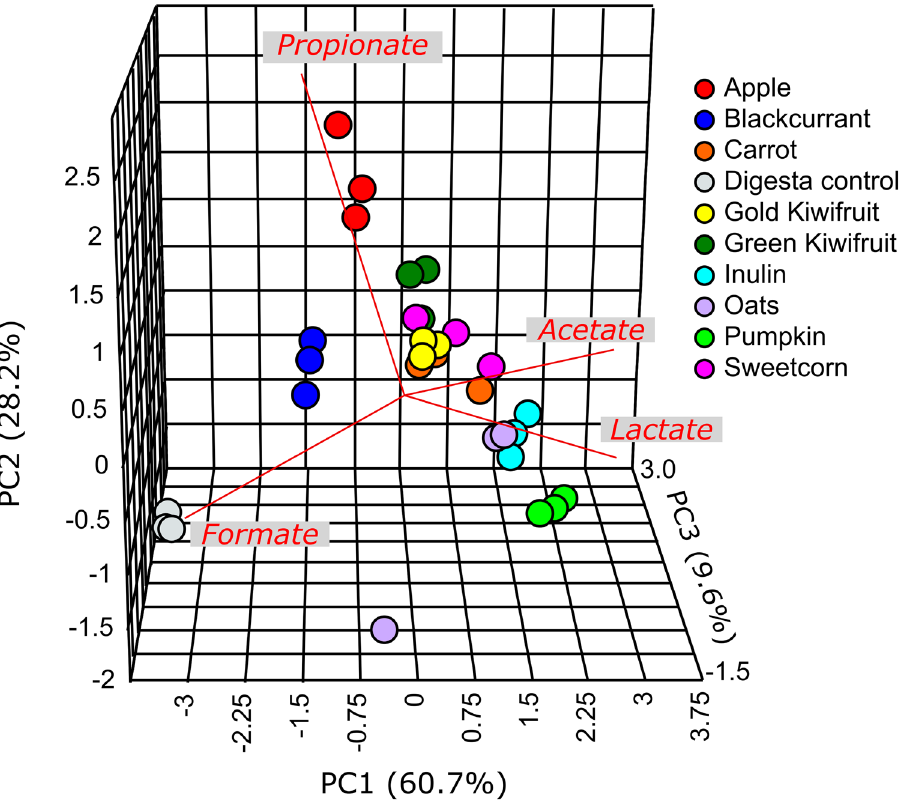
Figure 2. Principal component analysis plot visualising the changes in the organic acids after 10 h of fermentation of the foods and the two controls, inulin and water digesta. The acids that influence the loading are appended to the plot in